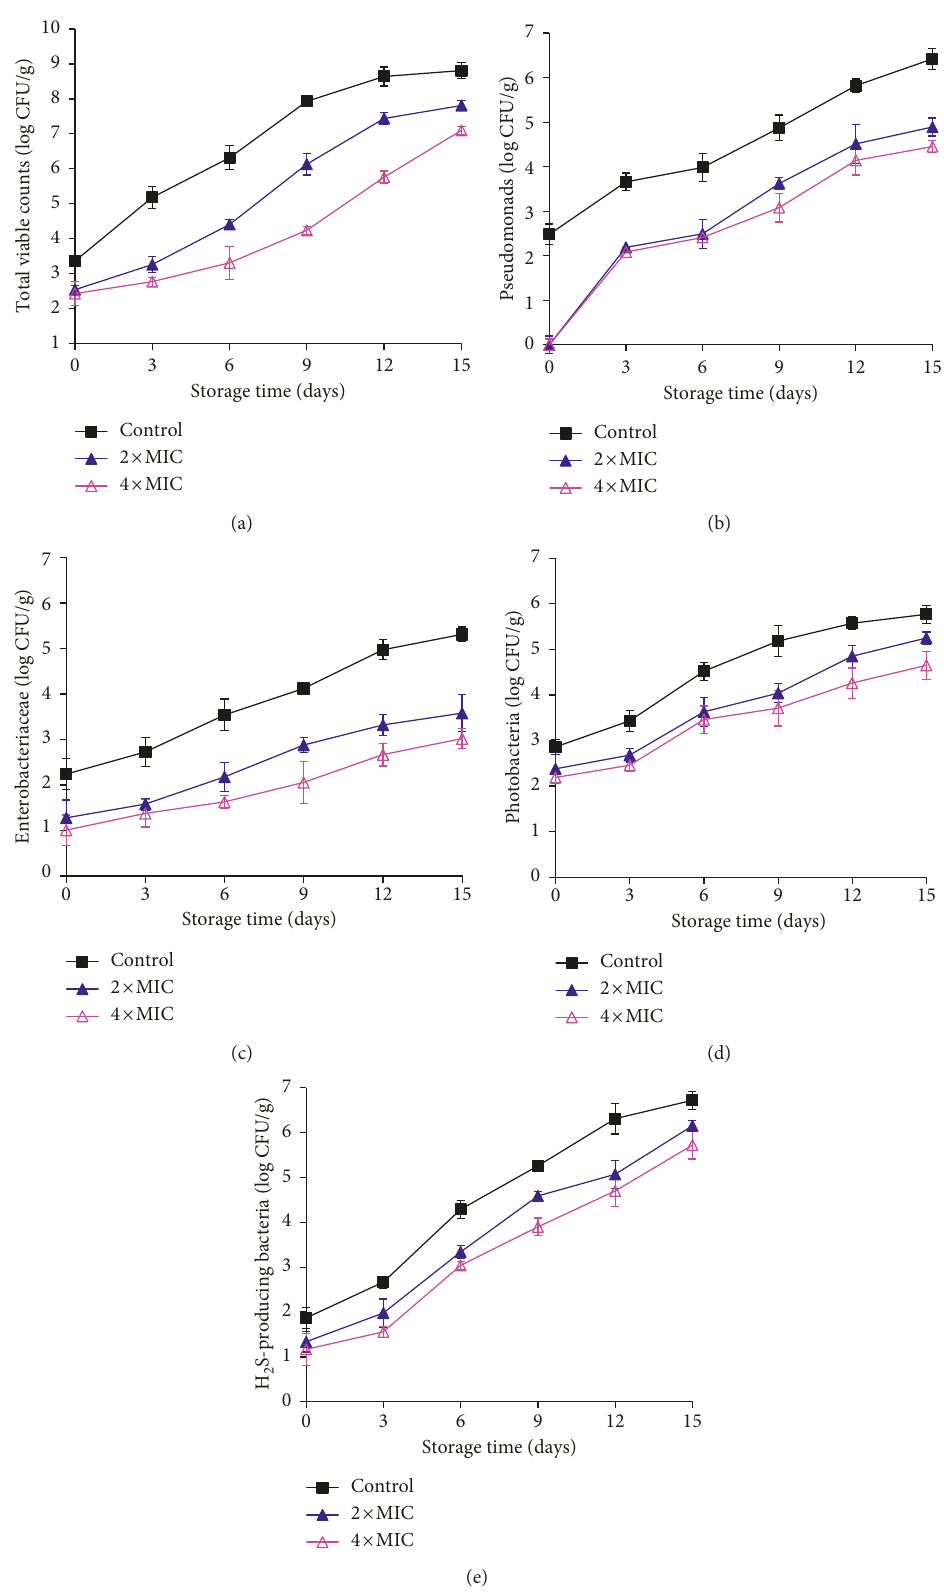
Figure 2: Changes in total viable counts (a), Pseudomonas (b), Enterobacteriaceae (c), Photobacterium (d), and H of chilled mackerel fillets packed with the films incorporated without/with 2